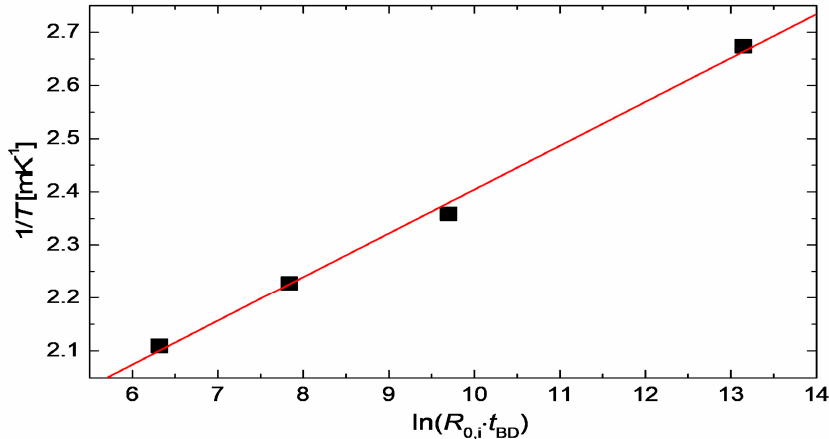
Figure 13. Temperature-breakdown time dependence for the data from Figure 5b. The solid line represents a linear fit to the experimental data, in agreement with Equation (10).